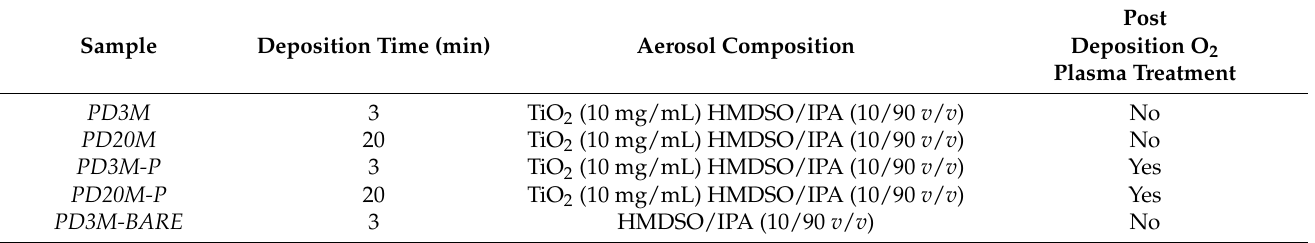
Table 1. Summary of the experimental parameters of the coating preparations (24 kHz/5 kV pp